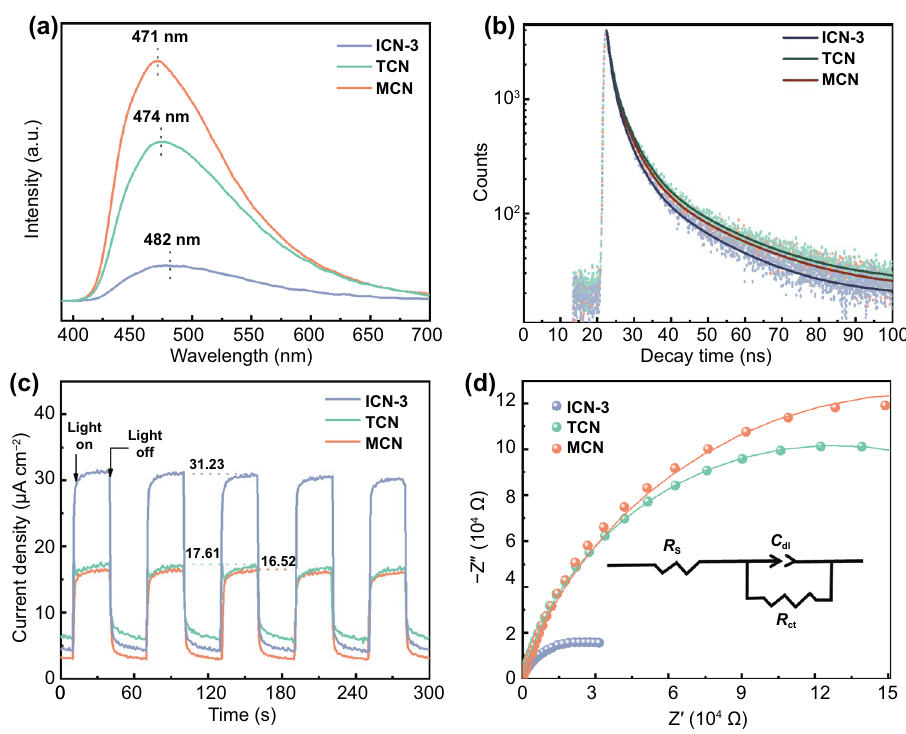
Fig. 4 a Steady-state photoluminescence spectroscopy, b time-resolved photoluminescence spectroscopy, c transient photocurrent response, and d electrochemical impedance spectroscopy of photocatalysts